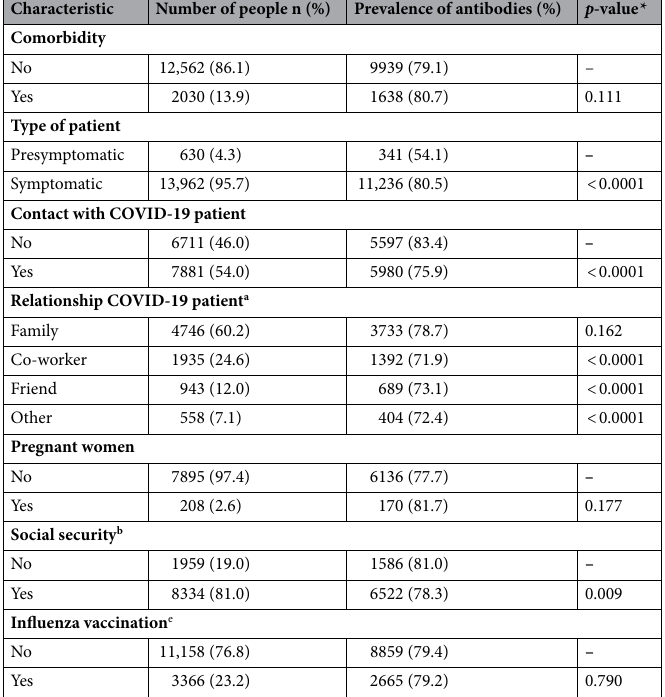
Table 2. Clinical and lifestyle characteristics of 14,592 people with SARS-CoV-2 antibodies previously diagnosed with COVID-19 by PCR test. a It should be noted that some categories can be counted more than once; b Missing values = 4299; c Missing values = 68. * p -values for x 2 test seroprevalence within groups.